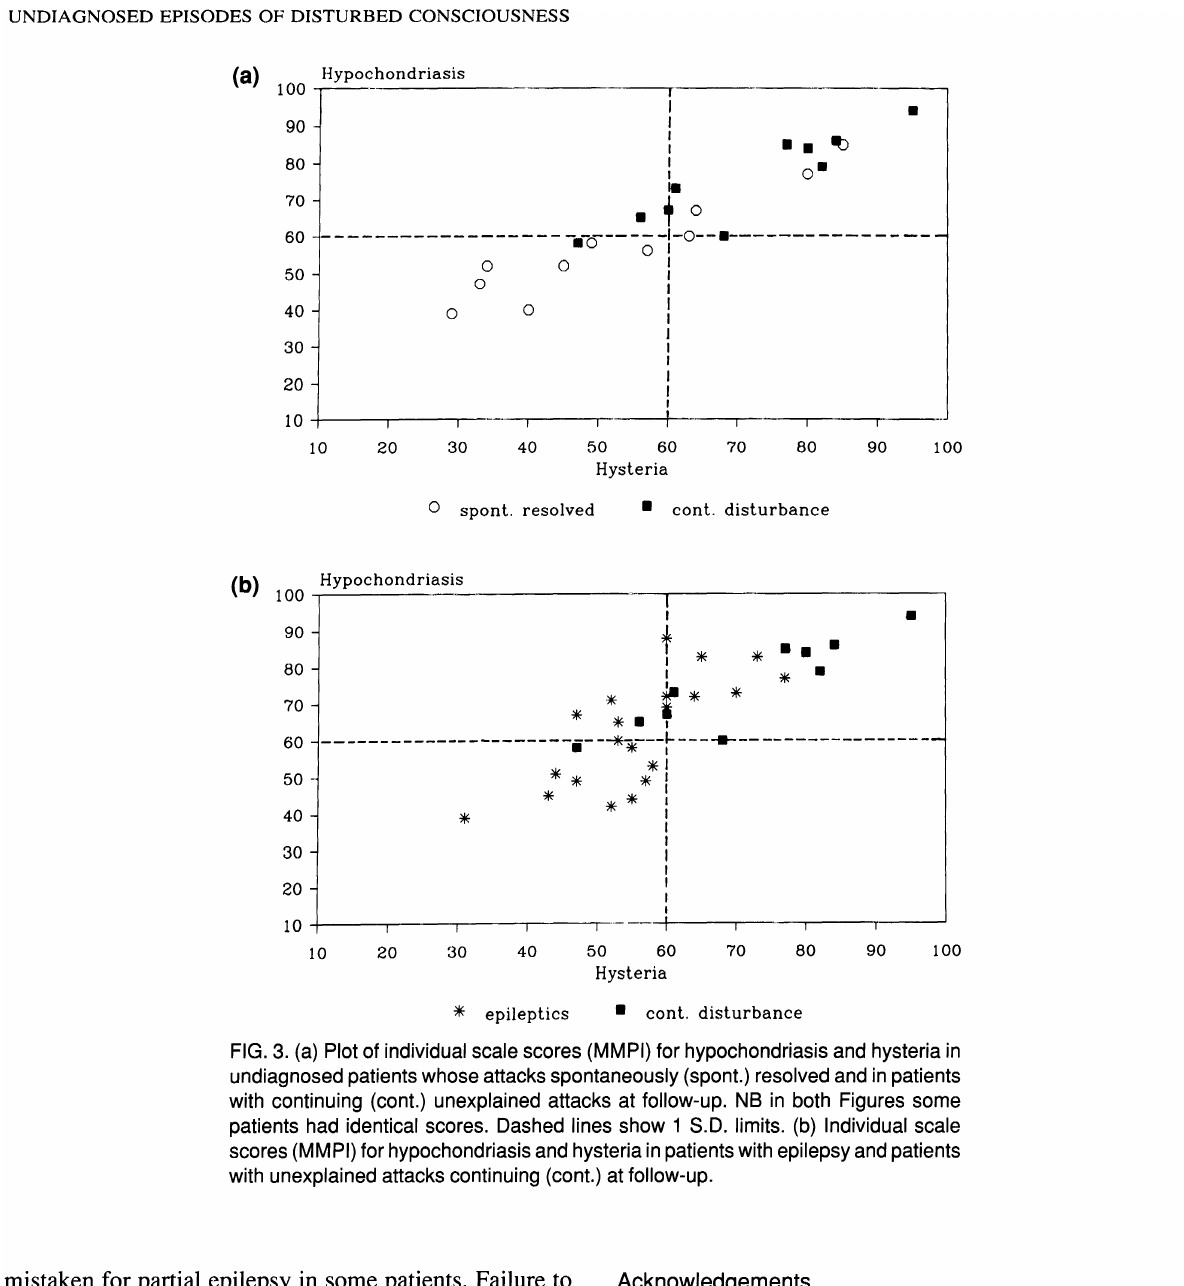
FIG. 3. (a) Plot of individual scale scores (MMPI) for hypochondriasis and hysteria in undiagnosed patients whose attacks spontaneously (spont.) resolved and in patients with continuing (cont.) unexplained attacks at follow-up. NB in both Figures some patients had identical scores. Dashed lines show 1 S.D. limits. (b) Individual scale scores (MMPI) for hypochondriasis and hysteria in patients with epilepsy and patients with unexplained attacks continuing (cont.) at